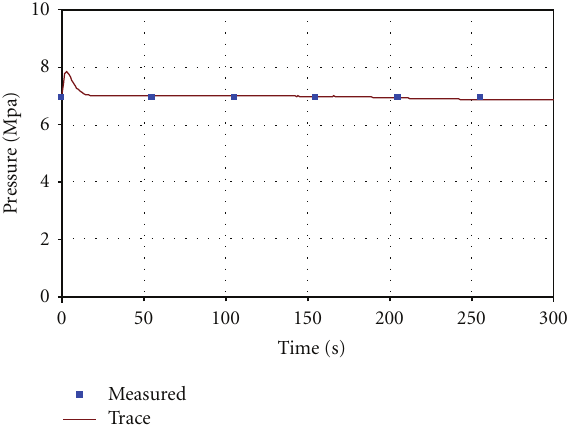
Figure 15: Comparison of predicted and measured dome pressure during transient.